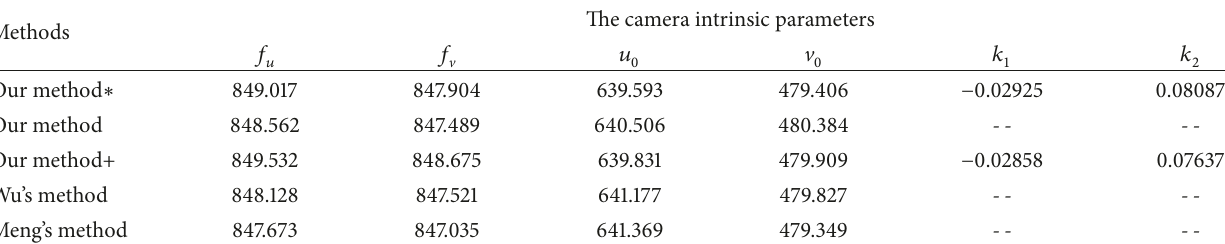
Table 1: Real experiment results for the camera intrinsic parameters (unit: